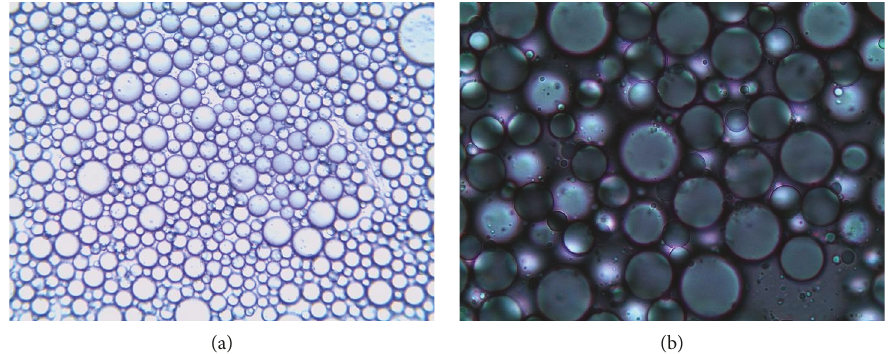
Figure 6: Microscopy images of the structure of model oil/water emulsions prepared with pectin. (a) 400x and (b) 1000x magni fi